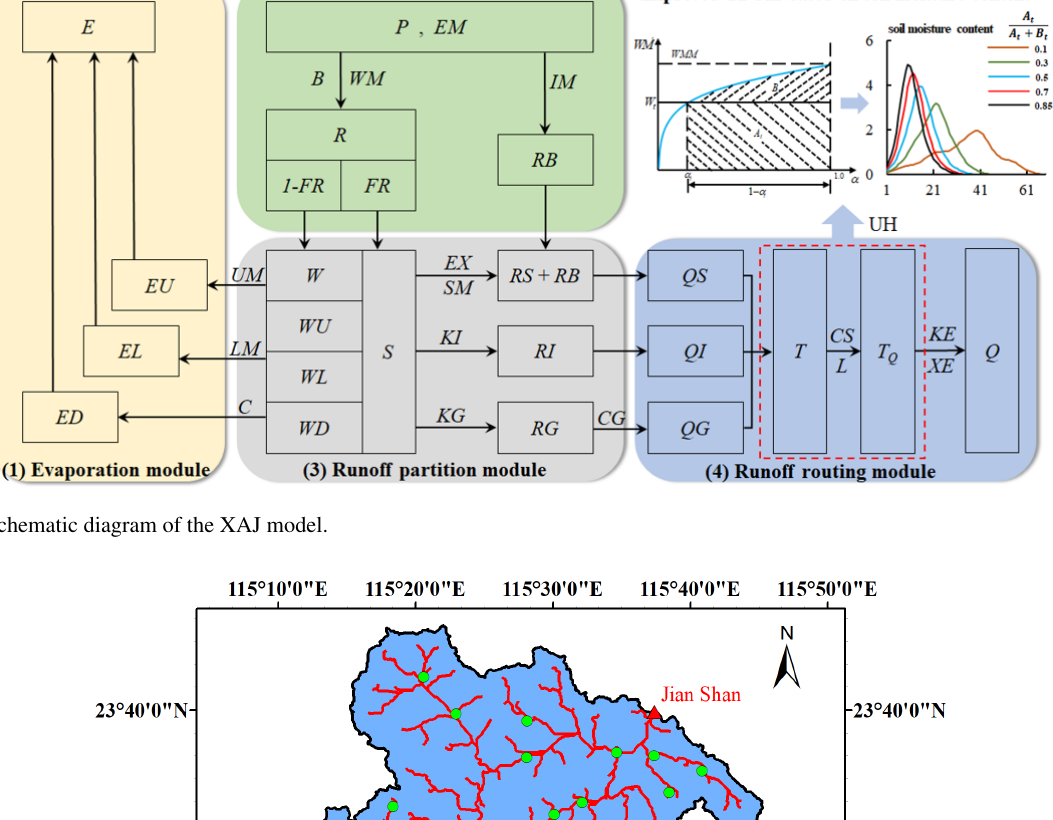
Figure 3. Schematic diagram of the XAJ model.